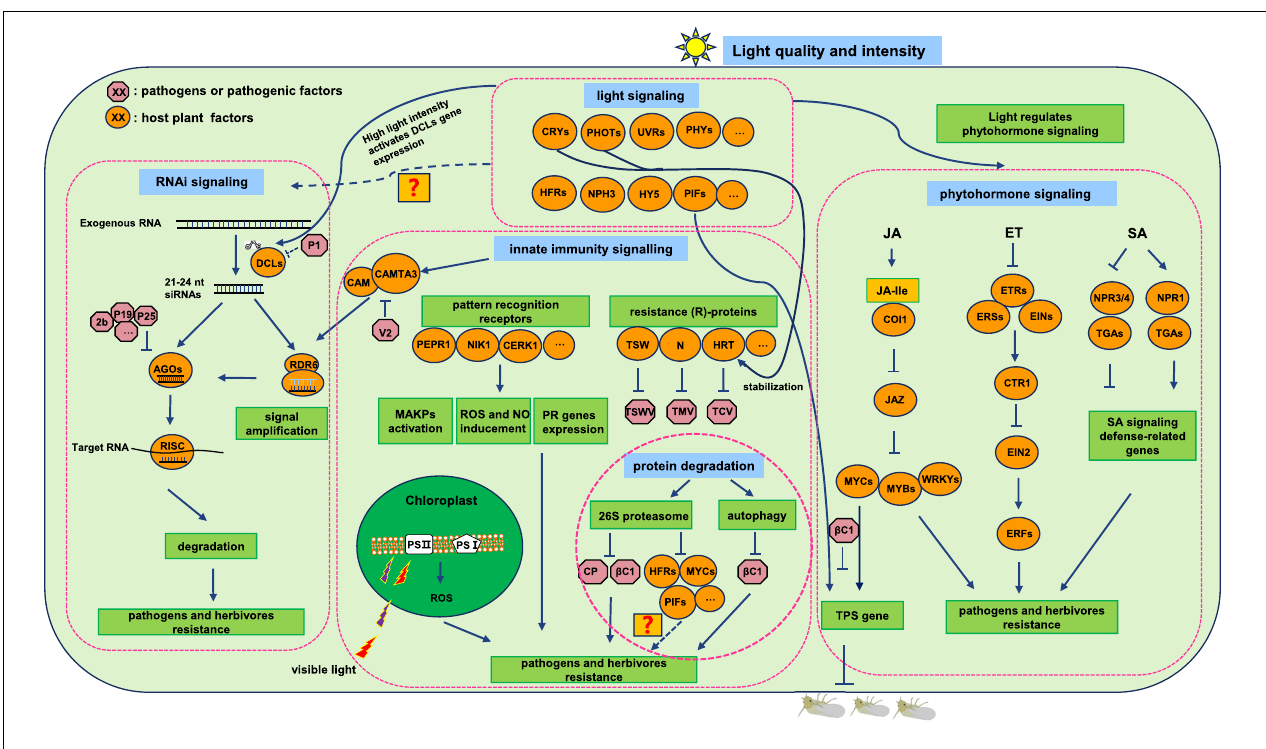
FIGURE 1 | Light-regulated plant defense